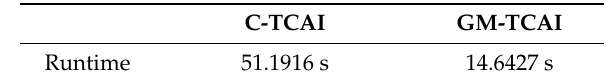
Table 4. Runtime for extended target.